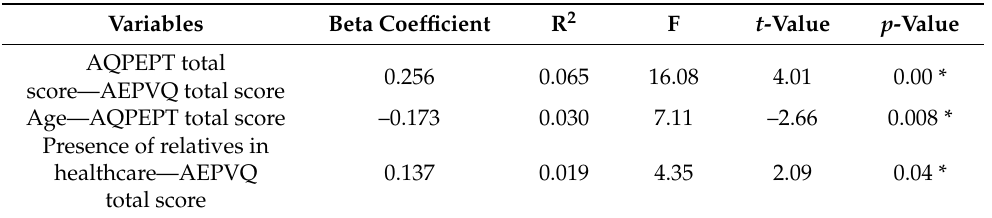
Table 4. Linear regressions performed to examine the prediction of attitudes on professional values, the prediction of age on attitudes, and the prediction the presence of relatives in healthcare predicted for professional